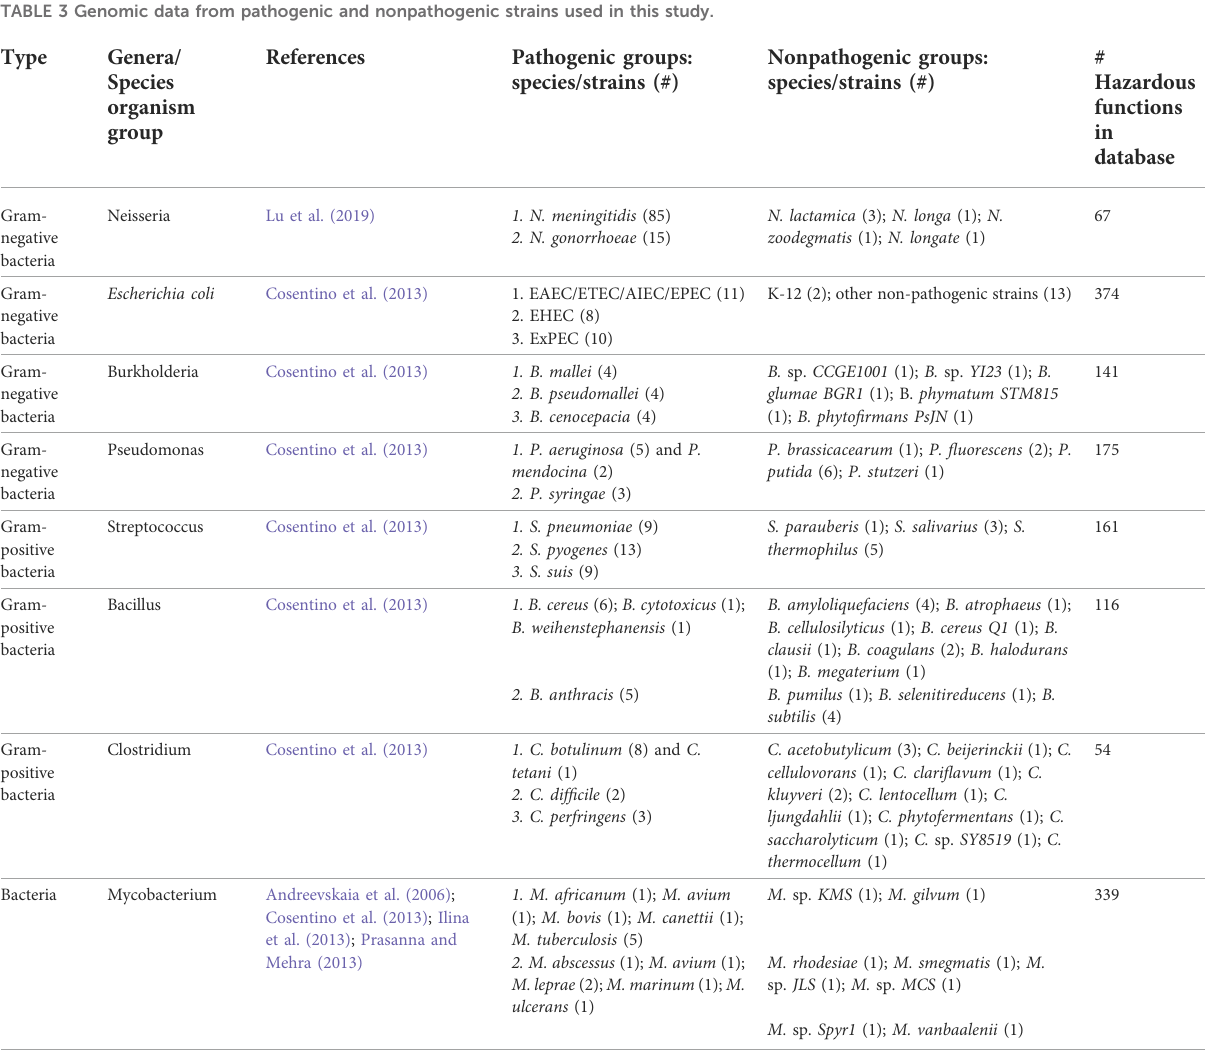
TABLE 3 Genomic data from pathogenic and nonpathogenic strains used in this